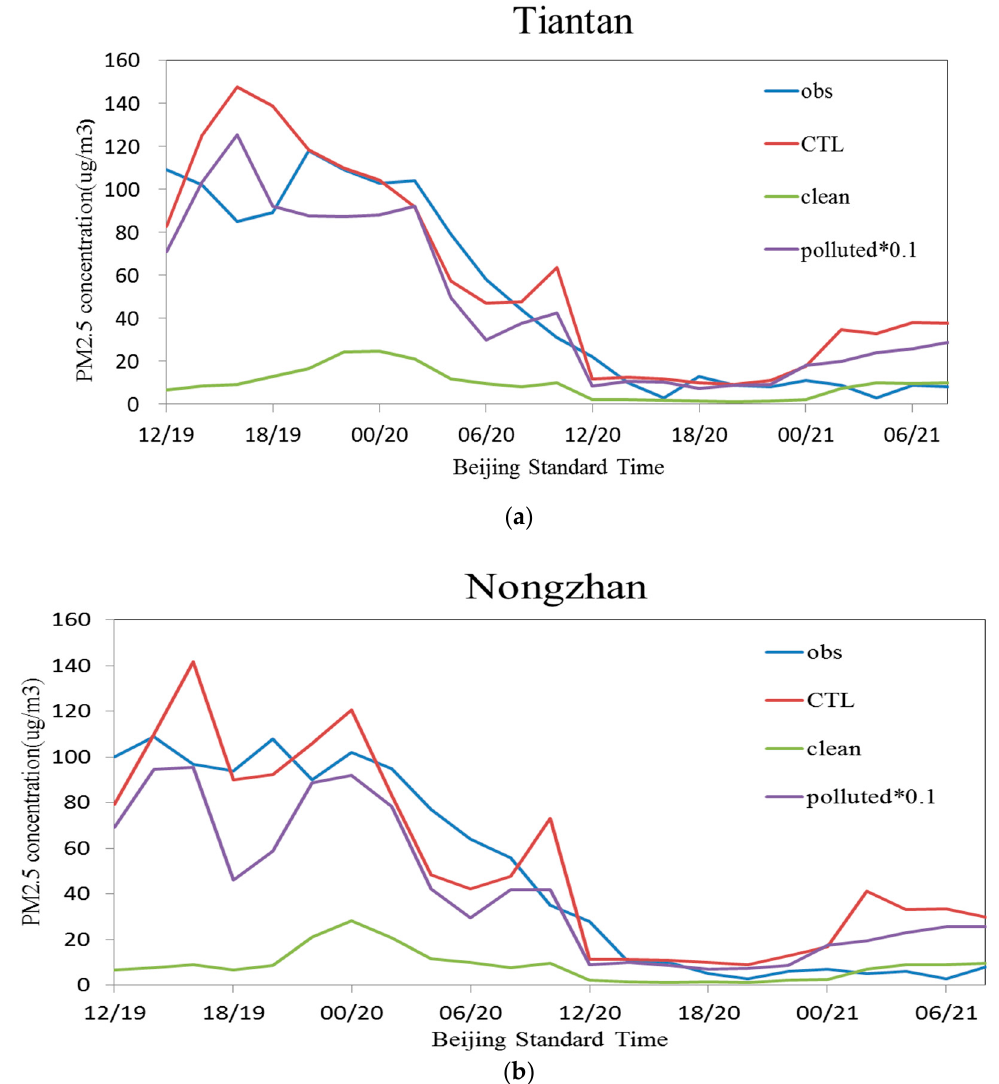
Figure 3. The variations of PM 2.5 concentrations over time in the observation, CTL, clean, and polluted tests (unit: μ g m − 3 , the values in the polluted test are multiplied by 0.1) at ( a ) Tiantan station and ( b ) Nongzhan station.